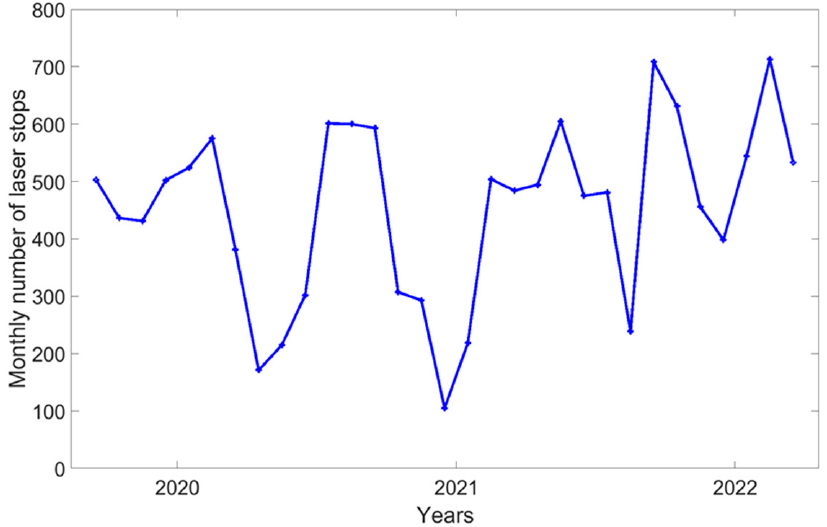
Figure 6. Monthly number of laser stops.